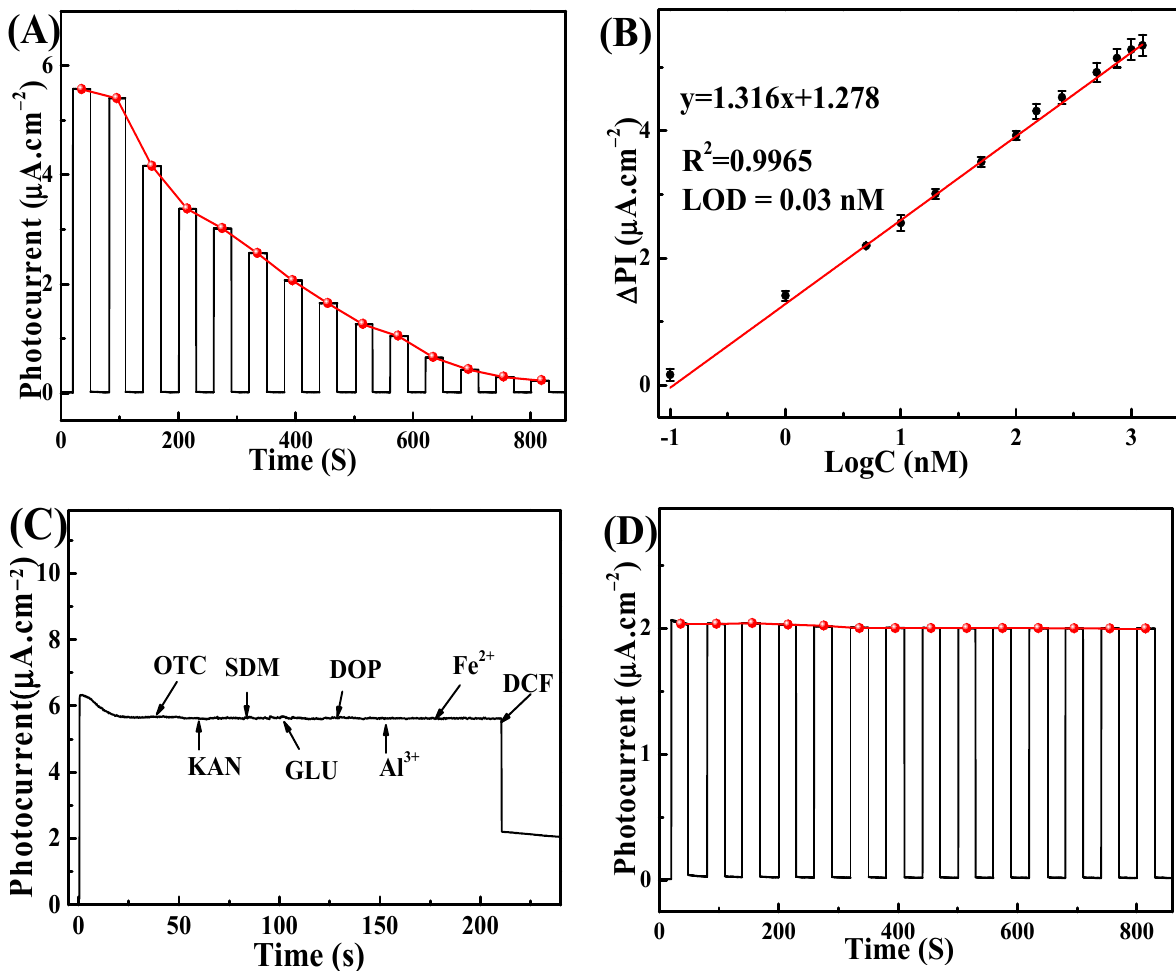
Figure 8. ( A ) Photocurrent responses of the aptamer/CS/CuS/MoS 2 /Bi 2 WO 6 -5% at various DCF levels in PBS (0.1 M, pH 7.0) at a bias potential of 0.1 V: (0.1–500 nM). ( B ) The linear calibration curve for STR determination. ( C ) Selectivity and ( D ) stability of the PEC sensor based on aptamer/CS/CuS/MoS 2 /Bi 2 WO 6 -5% for DCF detection. to Figure 8C, after waiting for the photocurrent of ap- fadimethoxine (SDM), ochratoxin A (OTA), dopamine (DOP), glucose (GLU), Al 3+ , and Fe 2+